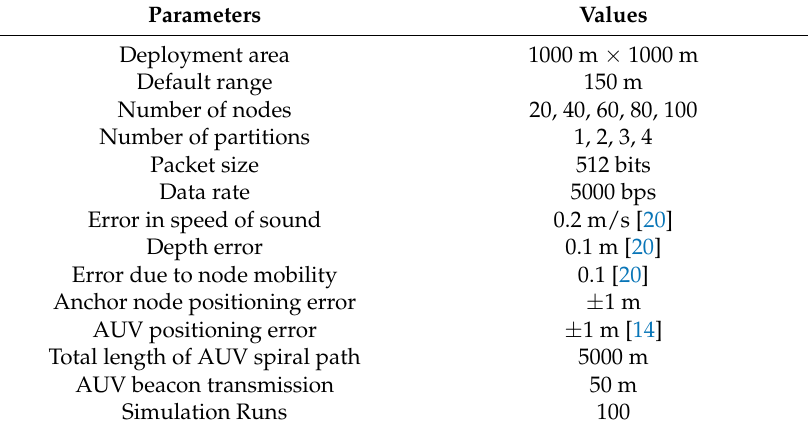
Table 1. Simulation